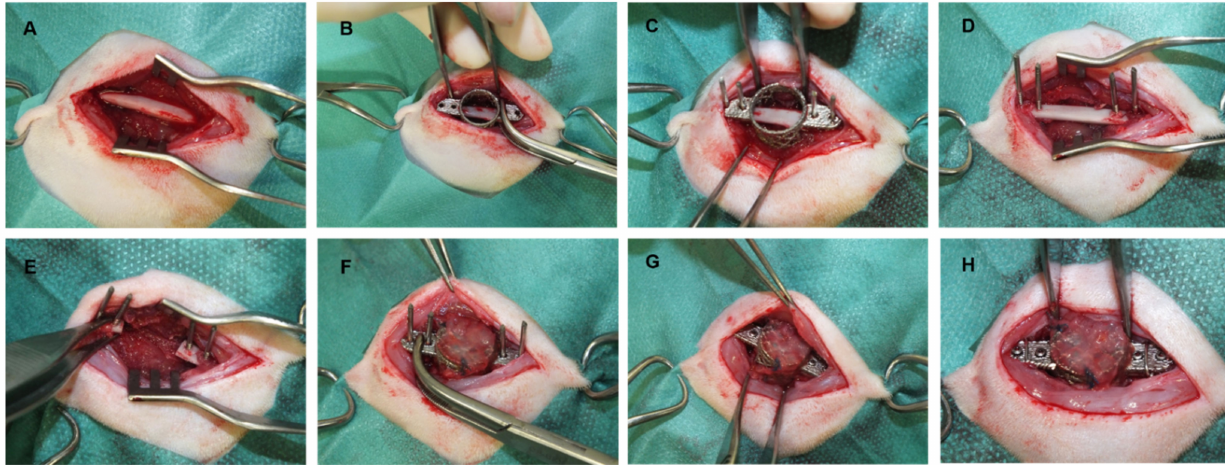
Figure 2. CSFD surgery. After exposure of the femur ( A ), Kirschner wire pins were positioned using an empty template chamber ( B – D ), and a 10 mm piece of the femoral shaft was removed ( E ). The prevascularized construct was transferred from the donor to the acceptor animal and secured with screws and a cerclage wire ( F – H